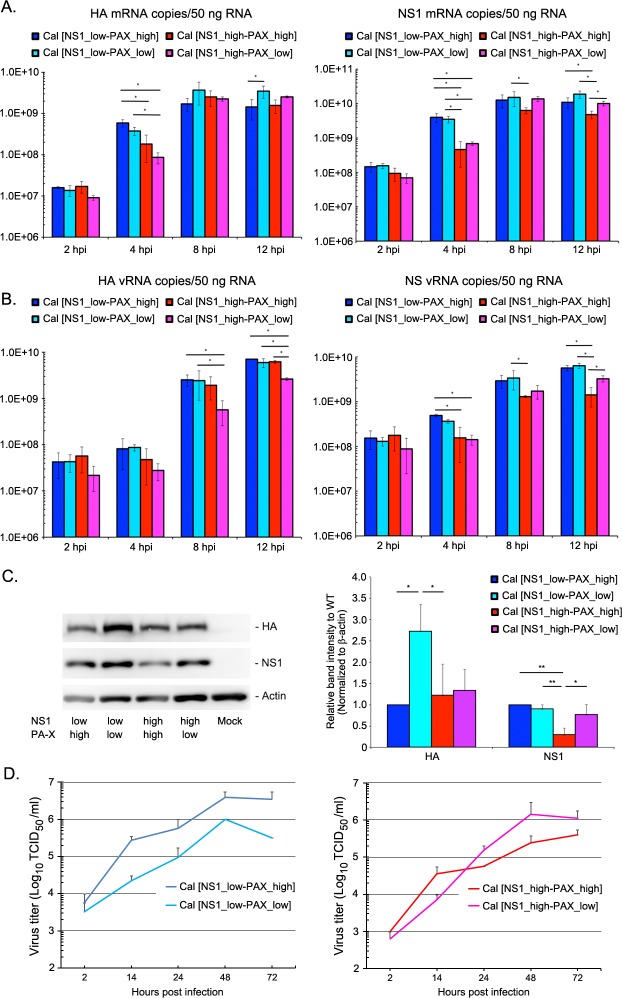
Expression of mRNA, vRNA and proteins of NS1 and HA, and growth of the viruses in Calu-3 cells.A549 cells were infected with the viruses at MOI of 2 and viral mRNA (A) and vRNA (B) were quantitated by qRT-PCR at various times after infection. The data represent averages with standard deviations (n = 3). *, P<0.05. (C) HA and NS1 protein expression in infected A549 cells were determined by Western blot analysis. Cellular actin protein was detected as a loading control. Left figure is a representative of three independent experiments and bar graph on right shows relative expression level (n = 3). *, P<0.05, **, P<0.01. (D) Multi-step growth of the viruses were determined in human airway Calu-3 cells. Cells were infected at MOI of 0.1 and released progeny virions in the culture supernatants at various time points were titrated. The data represent averages with standard deviations (n = 3).